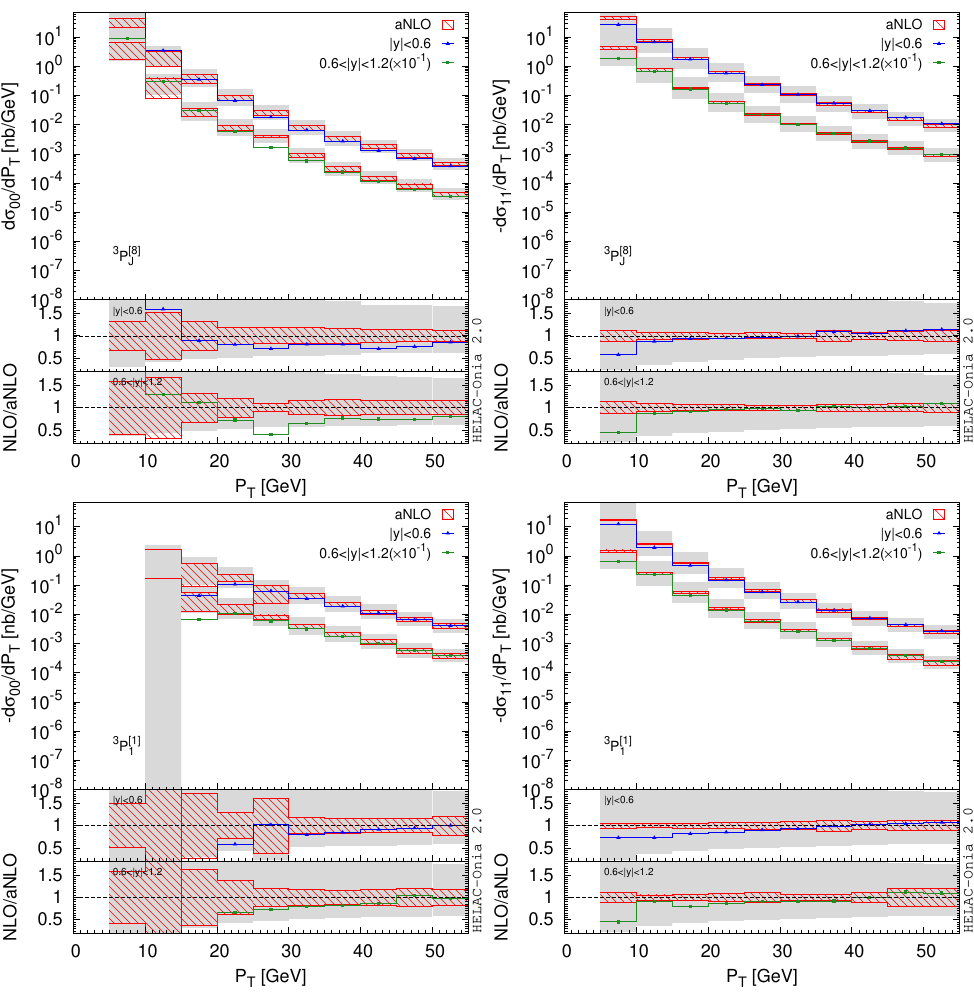
Figure 19 . Comparisons of spin-dependent differential cross sections for the 2 Fock states 3 P [8] between our aNLO calculations and the complete NLO calculations. They are similar to figure